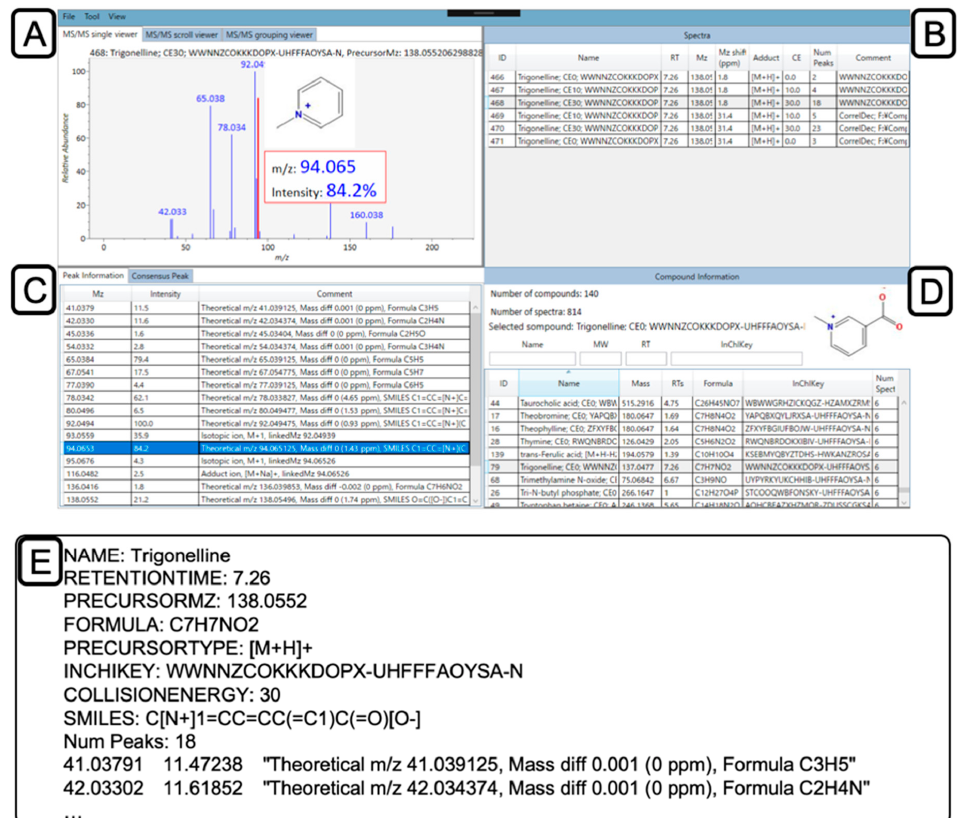
Figure 4. MS library organization and editing with MS-LIMA. ( A ) Visualization of MS spectrum with ( B ) editable annotations from MS-FINDER for each peak. ( C ) Available MS spectra for ( D ) a selected compound in loaded AMRT + MS2 library. ( E ) For MS-LIMA libraries, we recommend to include the following lines for each record with trigonelline as an